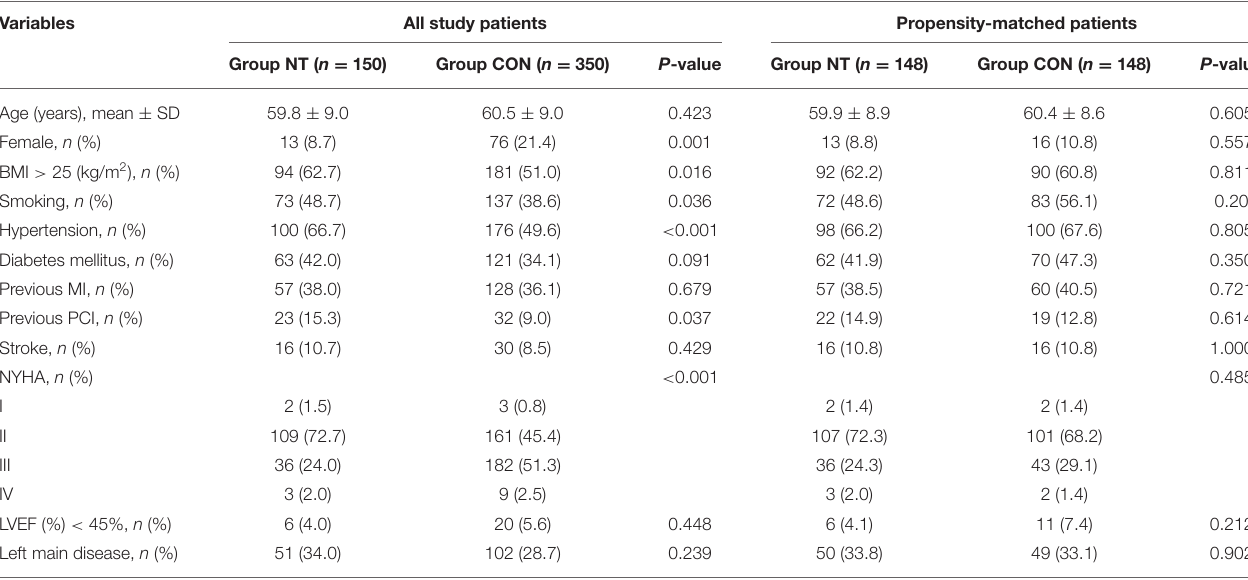
TABLE 1 | Preoperative characteristics and risk factors of study